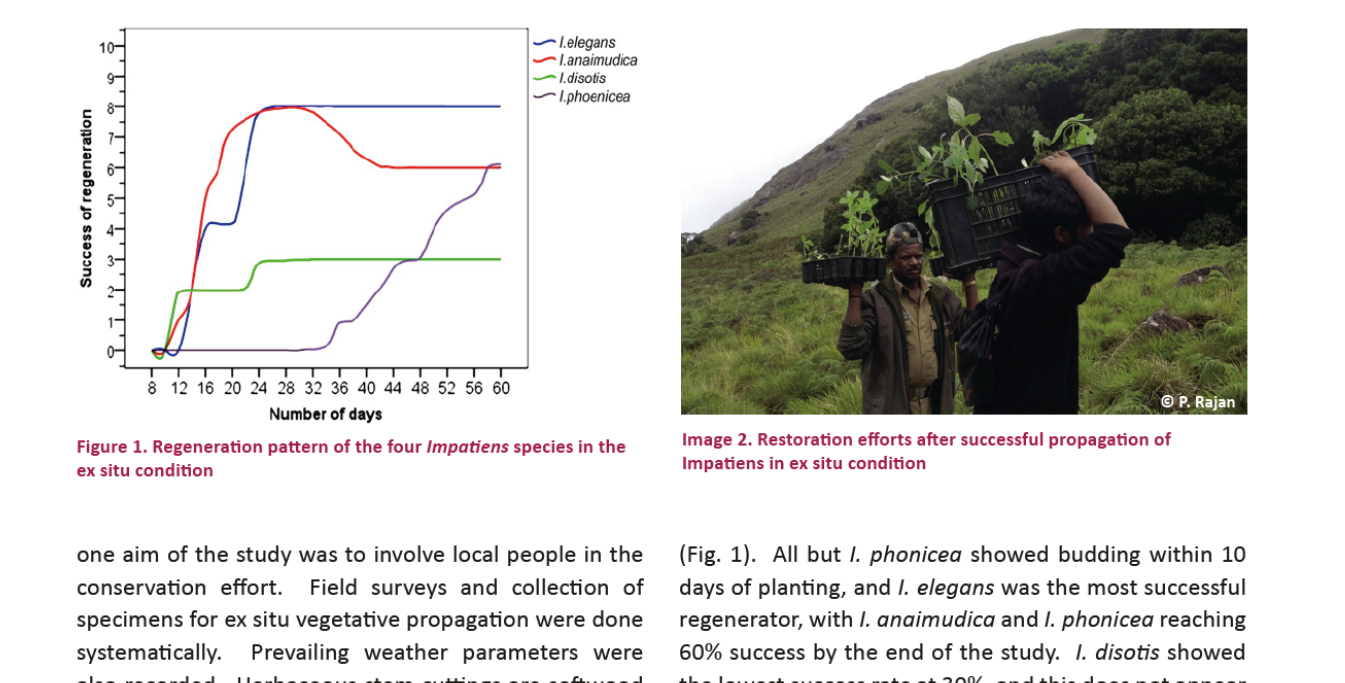
Ffigure 1. Regenerafion patern off the ffour Impafiens specfies fin the ex sfitu